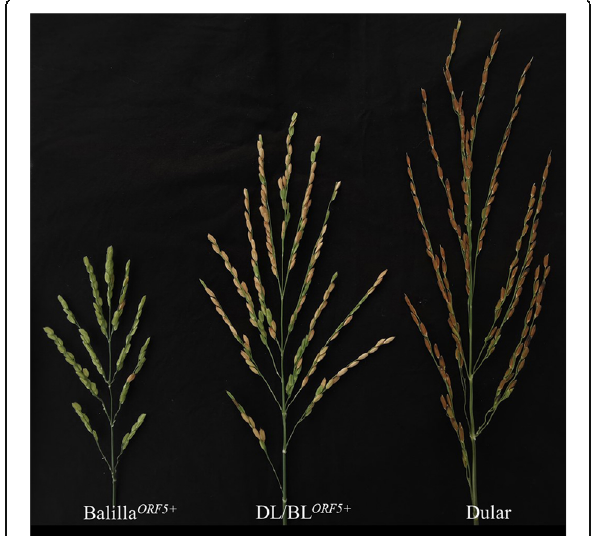
Fig. 1 Spikelet fertility of Balilla ORF5+ , Dular and DL/BL ORF5+ . The spikelet fertility of male parent Balilla ORF5+ was < 5%, while the female Dular parent exhibited normal spikelet fertility. Spikelet fertility of the hybrid F 1 (DL/BL ORF5+ ) was approximately 65%. DL, Dular; BL,